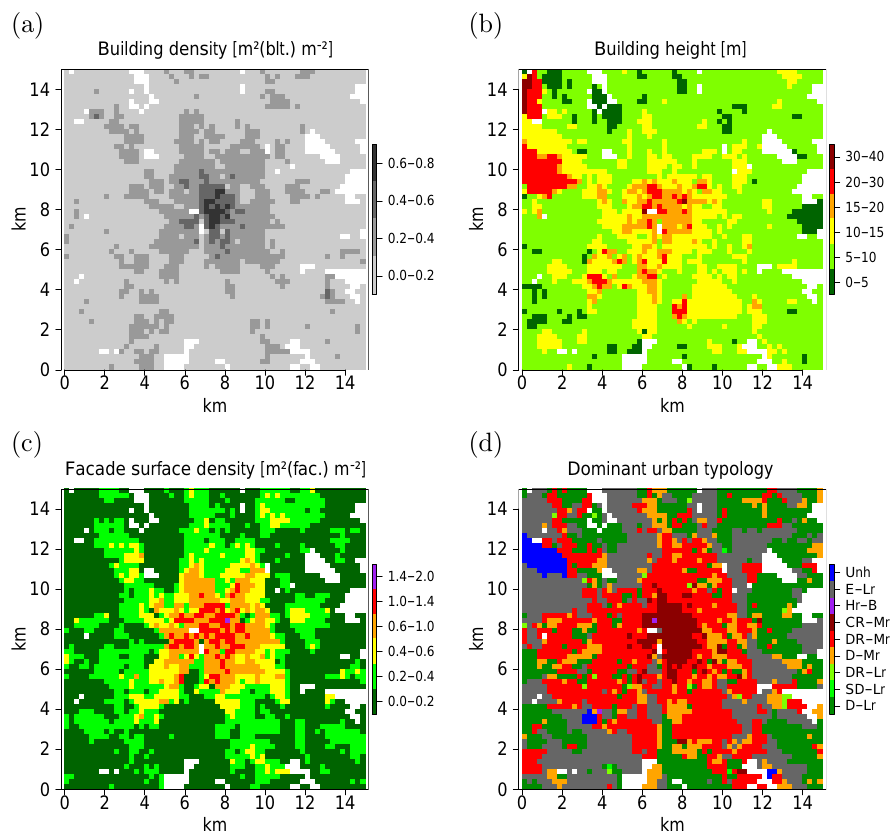
Figure 5. Urban morphology at a spatial resolution of 250m × 250m for the agglomeration of Toulouse. The prevailing dominant urban typologies are detached low rise (D-Lr), semi-detached low rise (SD-Lr), discontinuous rows of low rise (DR-Lr), detached mid-rise (D-Mr), discontinuous rows of mid-rise (DR-Mr), continuous rows of mid-rise (CR-Mr), high-rise building (Hr-B), extended low-rise (E-Lr) and unheated buildings